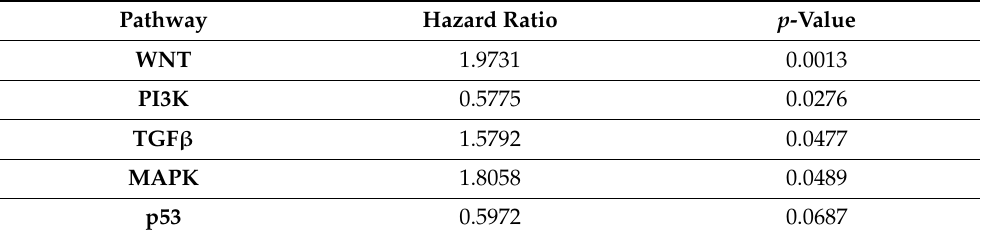
Table 5. The association between PROGENy pathway activity and patient event-free survival. PROGENy scores were analysed using Kaplan–Meier analysis and the log-rank test to obtain hazard ratios and p